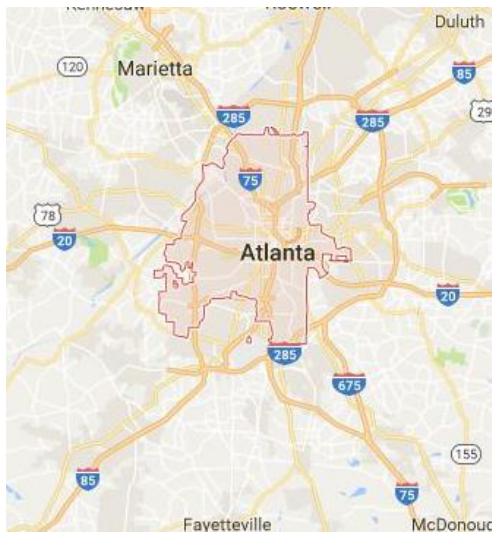
Figure 6. Crash intensity with triple-cube kernel